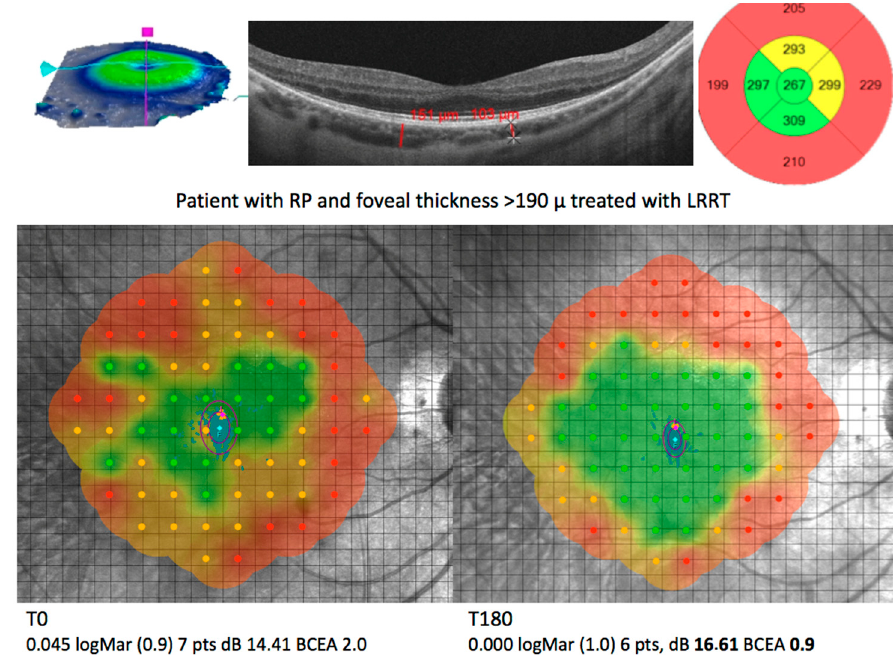
Figure 2. Image showing the effect of the suprachoroidal implantation of autologous mesenchymal cells in a patient with retinitis pigmentosa. The OCT shows the foveal area thickness; the thicker it is, the greater the interactions between growth factors and residual cells. It can explain the increase in visual performance (BCVA, dB, pts) at T180. Image courtesy of P. Limoli—Low Vision research Centre of Milan.